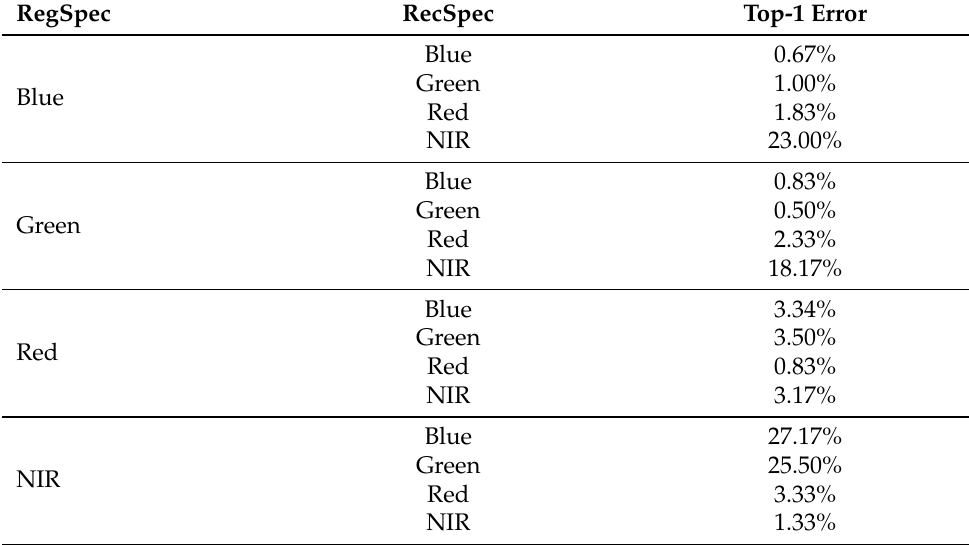
Table 1. Top-1 error results of cross-spectral E-BOCV without palmprint translation. RegSpec denotes the spectrum used in registration, while RecSpec in